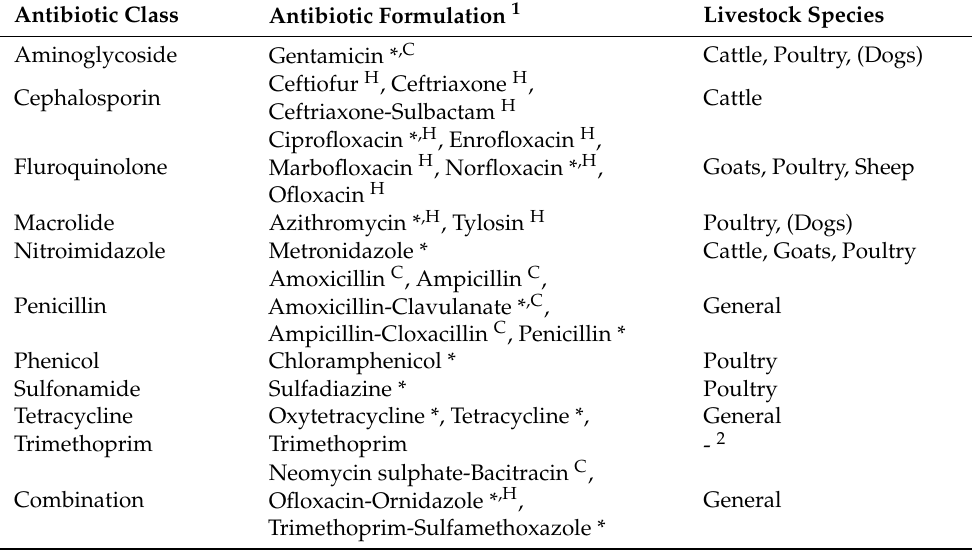
Table 4. Veterinary and human antibiotic formulations identified and used in